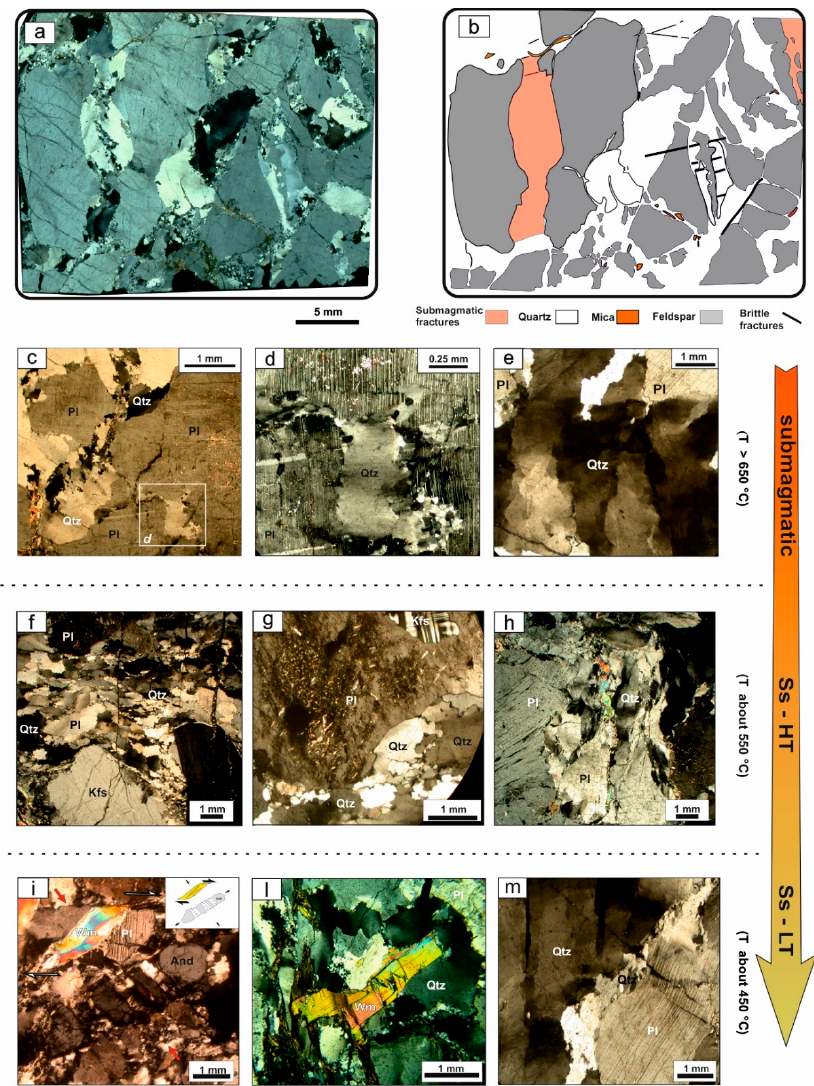
Figure 8. Shear-related deformation microstructures developed from sub-magmatic to low-temperature subsolidus conditions in the low-Ca granitoids (Ss-HT = Solid state High Temperature; Ss-LT = Solid state Low Temperature) (crossed polars) Abbreviations: Pl, plagioclase; Qtz, quartz; Kfs, K-feldspar; Wm, white mica; Bt, biotite; And, andalusite. ( a ) thin section scan of a representative a low-Ca specimen; ( b ) microtectonic sketch drawing of ( a ); ( c ) submagmatic fracture filled with quartz in plagioclase; ( d ) detail of quartz vein shown in c showing a lobate grain boundary between plagioclase and quartz, the latter showing subgrains as well as undulose extinction, due to subsequent deformation; ( e ) Chessboard pattern extinction in quartz; quartz sub-grain rotation recrystallization (SGR) microstructure also occur in the top left corner of the image; ( f ) subgrain rotation (SGR) associated with grain boundary migration recrystallization (GBM) at the edges of quartz relic grains; subvertical fractures dismembering feldspar grains also occur; ( g ) quartz domain with GBM and SGR; ( h ) stretched quartz grains showing ribbon-like shape, kinked plats of mica, and bended plagioclase twin planes; ( i ) two coupled kinematic indicators, given by mica-fish and boudinaged andalusite grain suggesting a dextral sense of shear ( σ 1 orientation is given by red arrows; see sketch in the inset for interpretation); ( l ) highly deformed mica in the centre of picture shows intense bending of (001) planes, whereas larger quartz grains show core-and-mantle structures together with bulging; ( m ) thin quartz-rich domain developed at the edge of a quartz grain with chessboard extinction pattern, that shows recrystallization of subgrains defining an oblique foliation near the border of the adjacent plagioclase